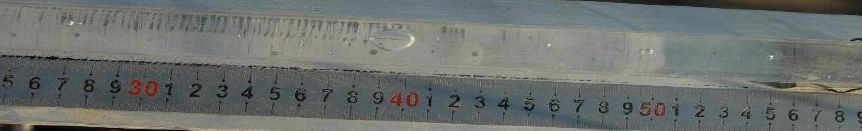
Figure 2. Pressure sensor and electronic vacuum manometer: ( a ) pressure sensor, ( b ) aeration electrode, ( c ) electronic vacuum pressure gauge.